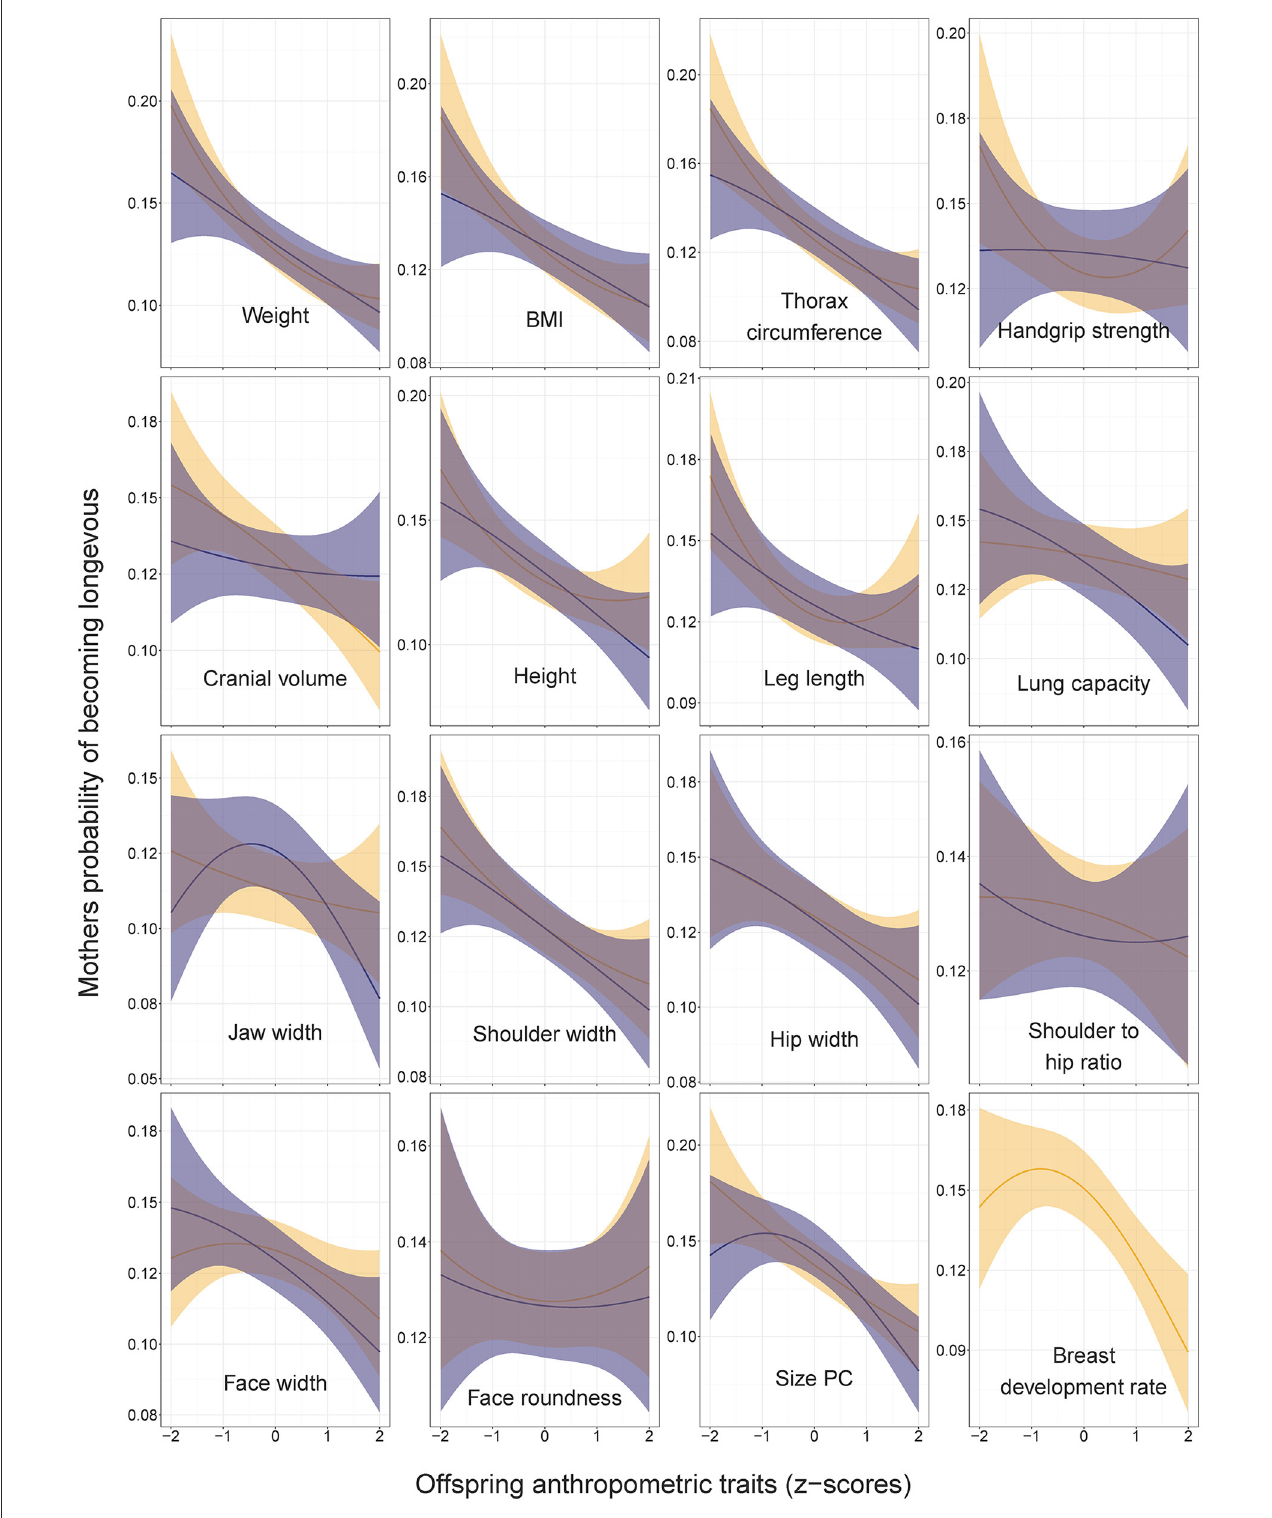
FIGURE3 Mothers’ probabilities of becoming longevous in relation to anthropometric traits of their sons (dark shading) and daughters (light shading). Predictions (with 95% CI) from the models without covariates: lrm[formula = longevity ∼ focal_trait + (focal_trait*focal_trait)]. Statistics are provided in Supplementary Table 1 in